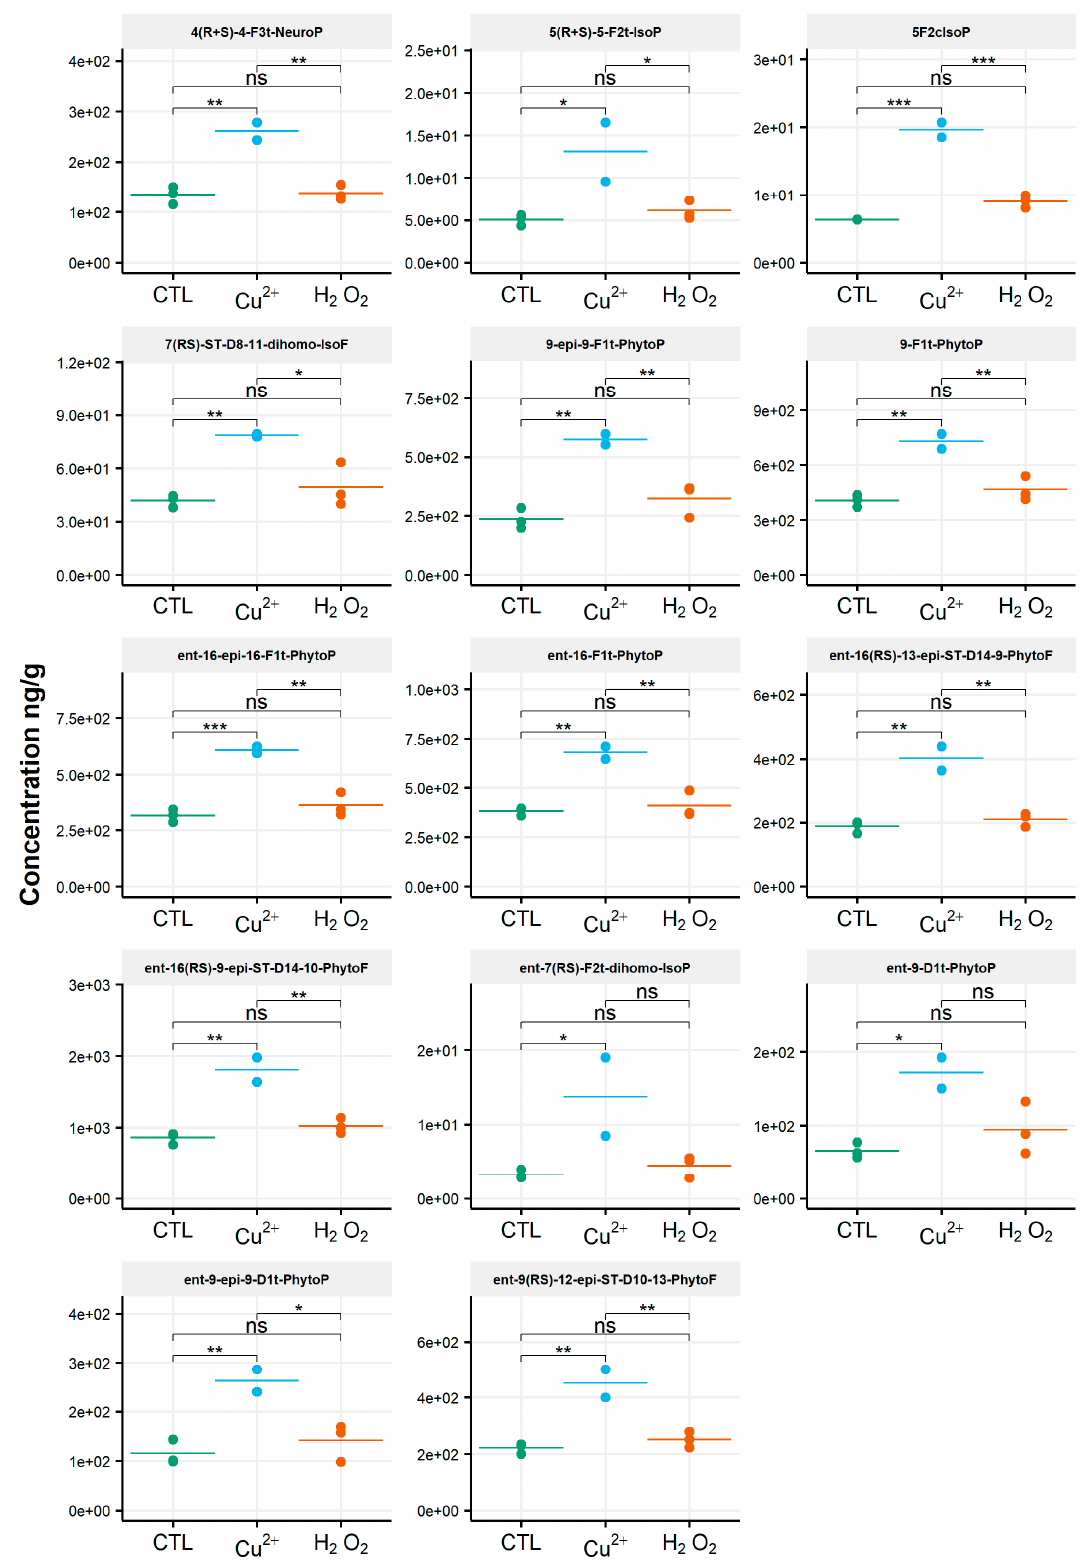
Figure 4. Changes in contents of selected isoprostanoids for the haptophyte Tisochrysis lutea between the control condition (CTL) and oxidative stress (Cu 2+ and H 2 O 2 ) conditions. Statistically relevant responses between the control and stress conditions (one-way ANOVA) are indicated by asterisks: * p < 5 × 10 − 2 , ** p < 5 × 10 − 3 and *** p < 5 × 10 − 4 ; ns, not significant.